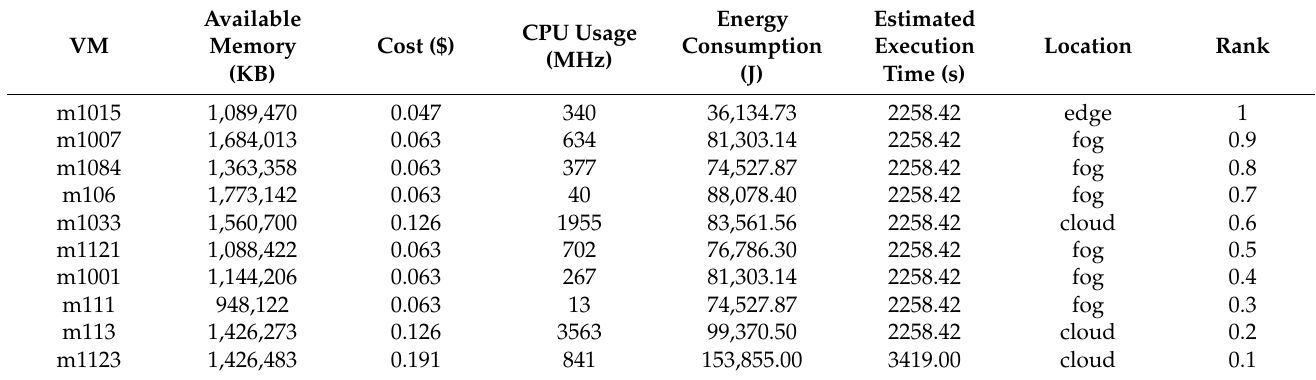
Table 20. Optimization results Task 334016 for a memory availability and energy consumption use